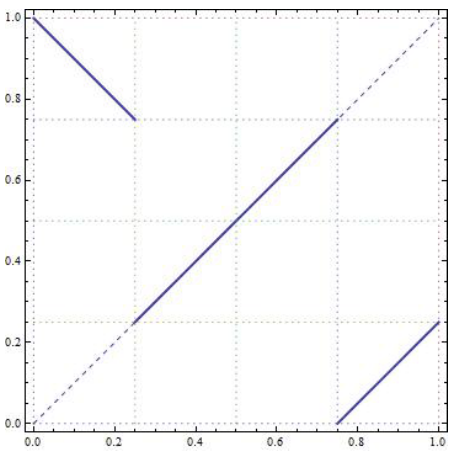
Figure 5. Graph of a ( 3,1 ) -IET with permutation ( − 3,2,1 ) and a =